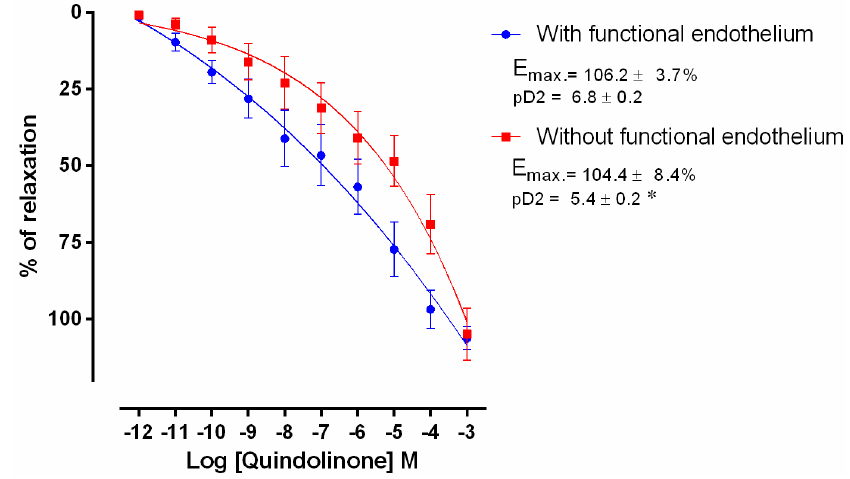
Figure 2. Concentration-response curve of quindolinone (10 − 12 –10 − 3 M) in cranial mesenteric artery rings isolated from rats with functional endothelium (•) and without functional endothelium ( ■ ) pre-contracted with phenylephrine (PHE, 1 μ M). Values are expressed as mean ± standard error of mean (SEM), * p < 0.05 compared to the ring with functional endothelium.